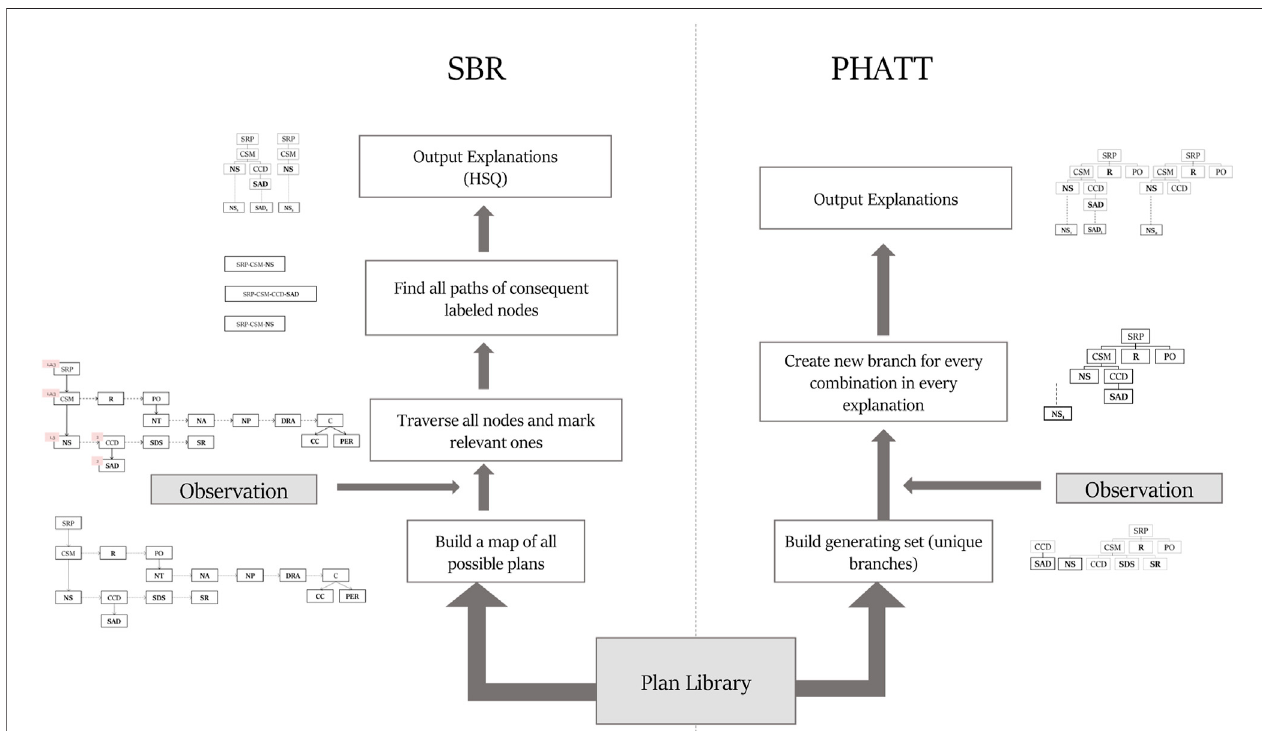
FIGURE 8 | Depiction of the fl ow differences between SBR and